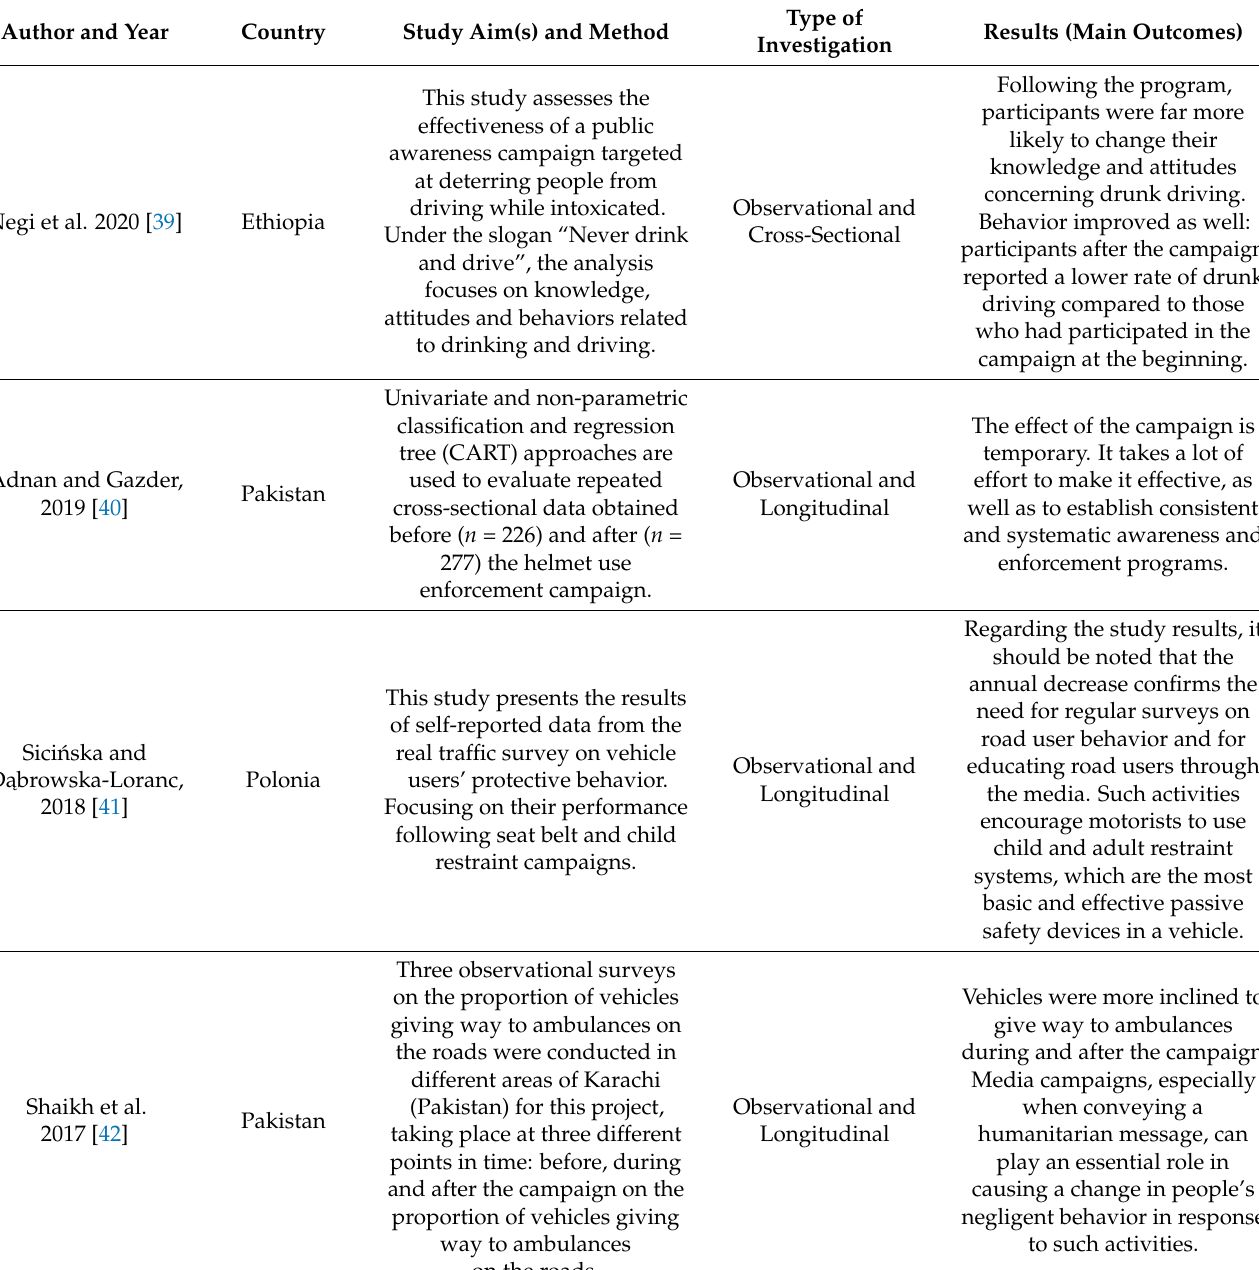
Table 1. General characteristics of eligible